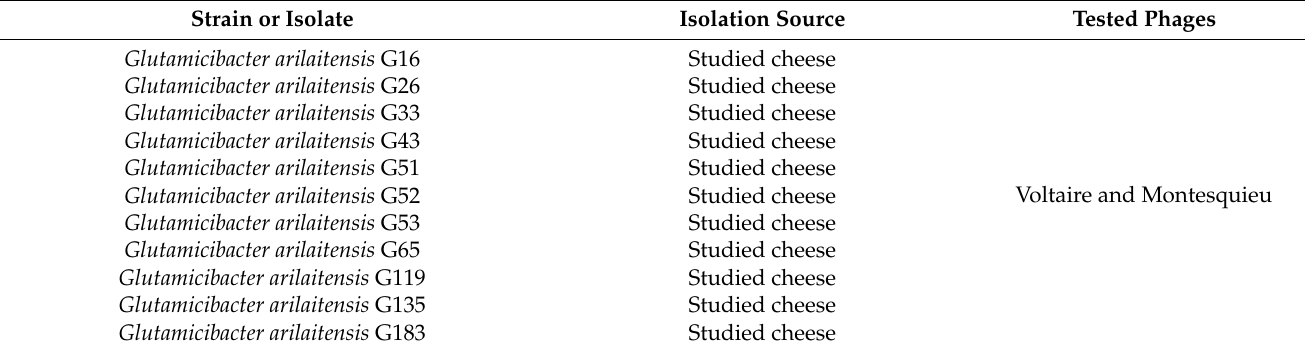
Table 1. Bacterial hosts tested for their sensitivity to isolated